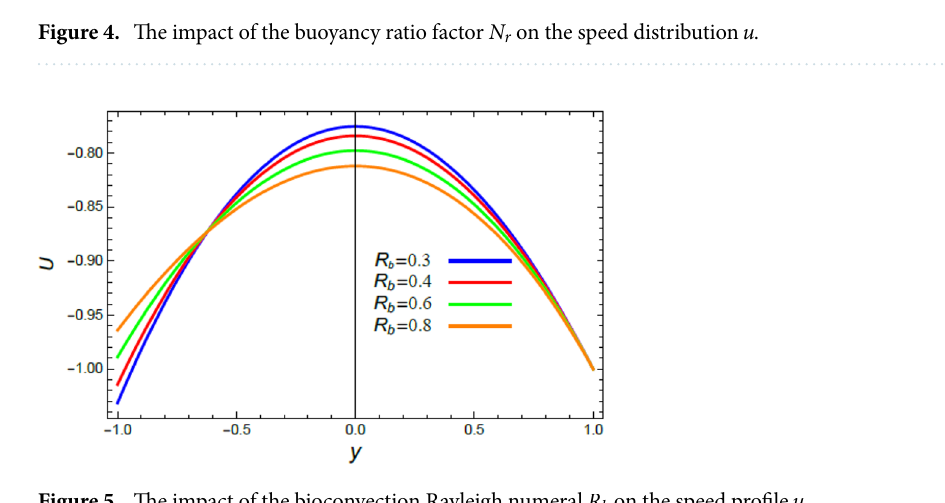
Figure 5. The impact of the bioconvection Rayleigh numeral R b on the speed profile u